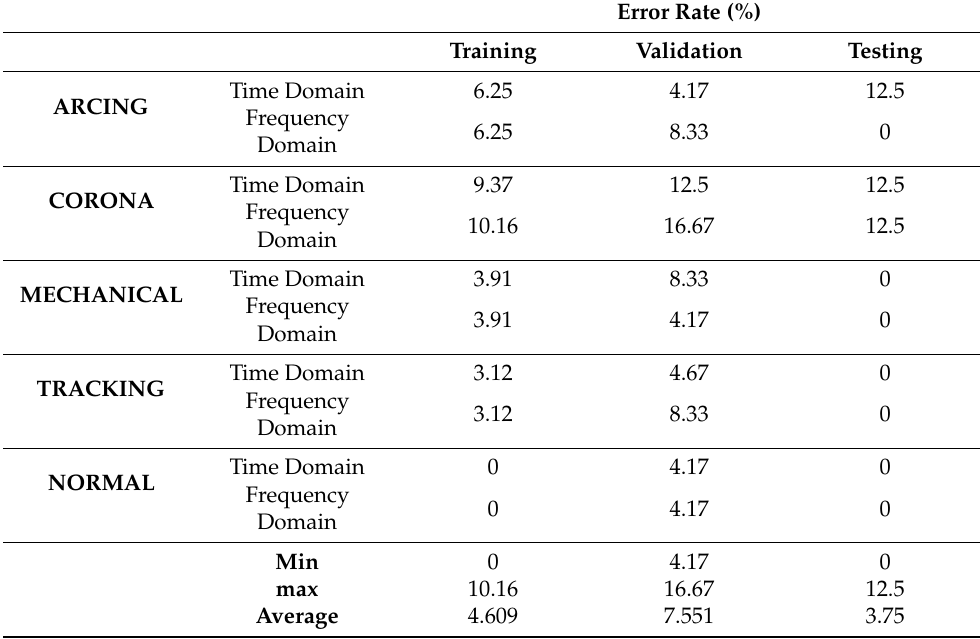
Table 15. Summary classification output of different switchgear faults in error